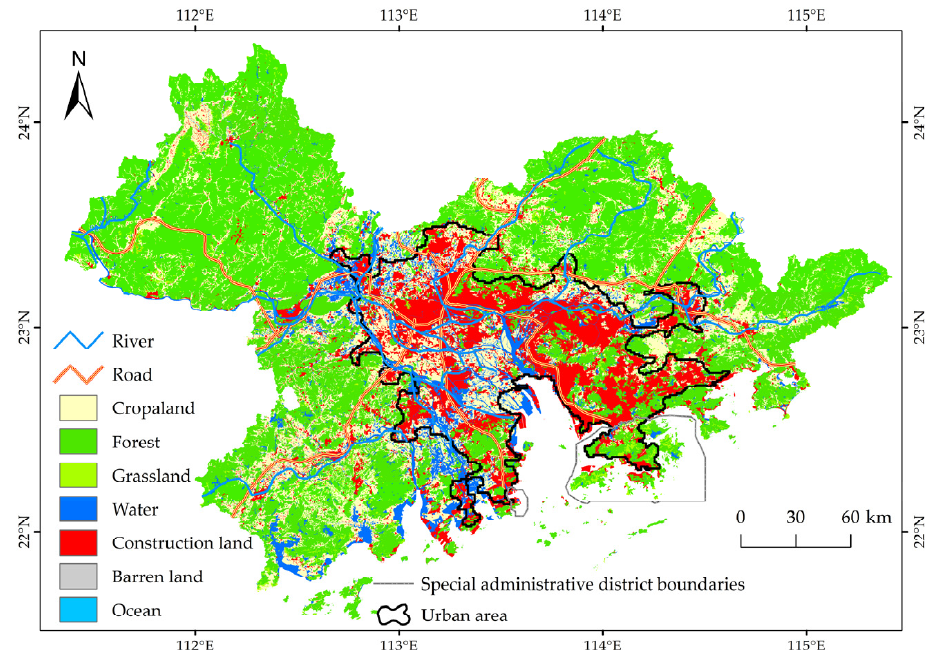
Figure 1. Study area in the Guangdong–Hong Kong–Macao Greater Bay Area. The land cover data were taken from [35].